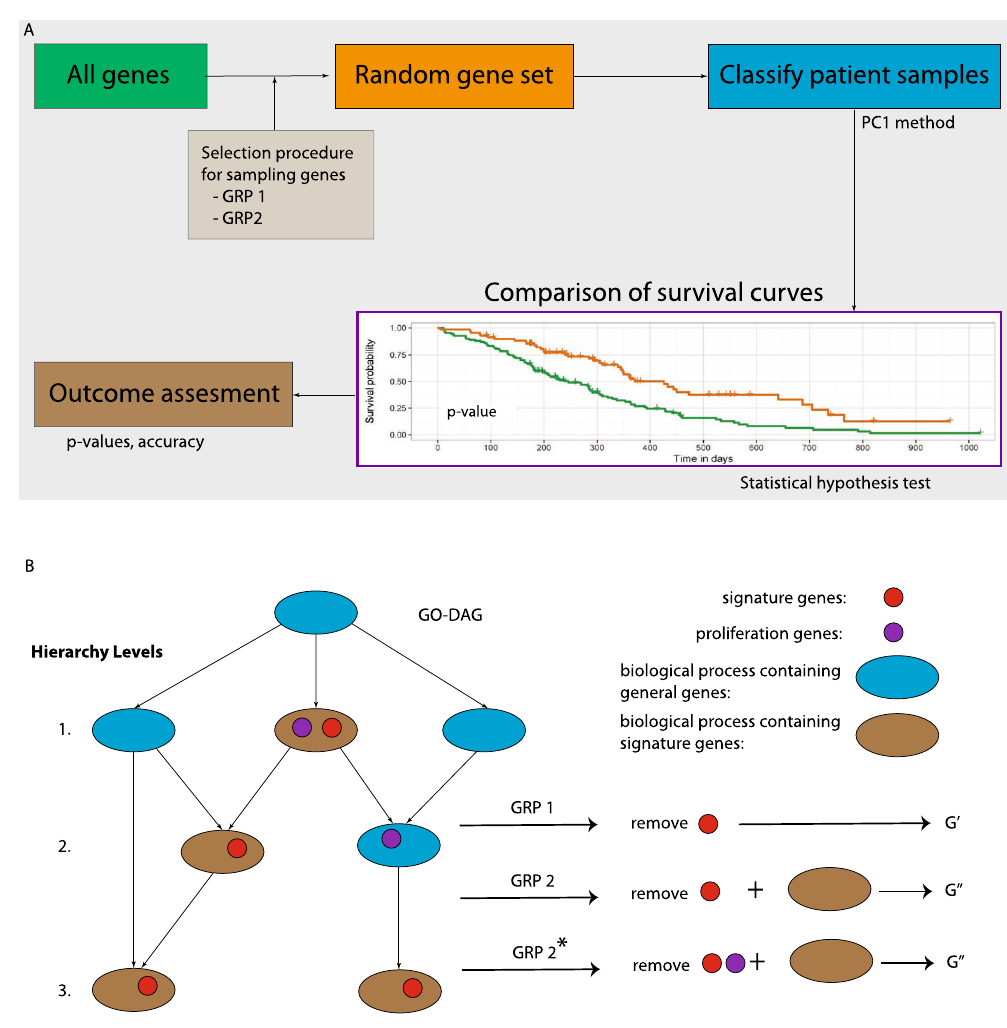
Figure 1. ( A ) Shown is a flowchart of all steps involved in our analysis. ( B ) Visualization of the underlying ideas of GRP 1 and GRP 2. The resulting gene sets G ′ and G ′′ are used for sampling random gene